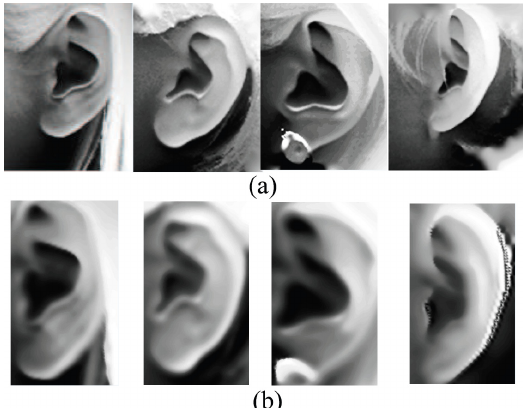
Figure 8. Ear normalization: ( a ) Coarsely extracted ear; ( b ) Normalized ear.